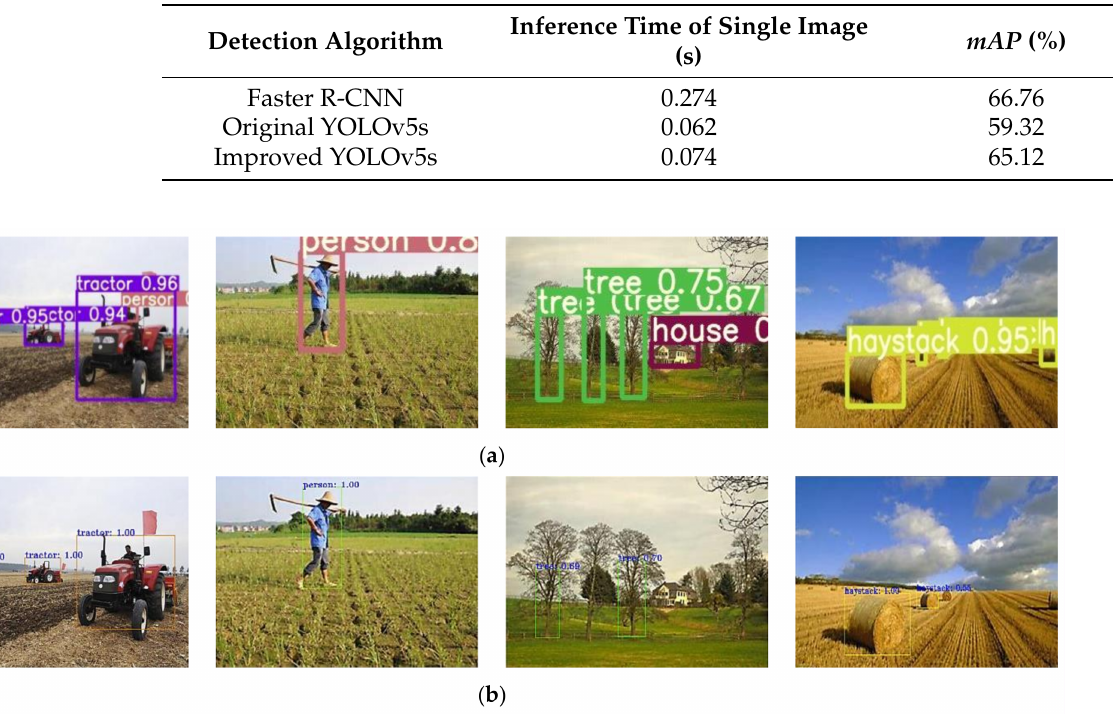
Table 4. Comparison of Faster R-CNN, original YOLOv5s and improved YOLOv5s.